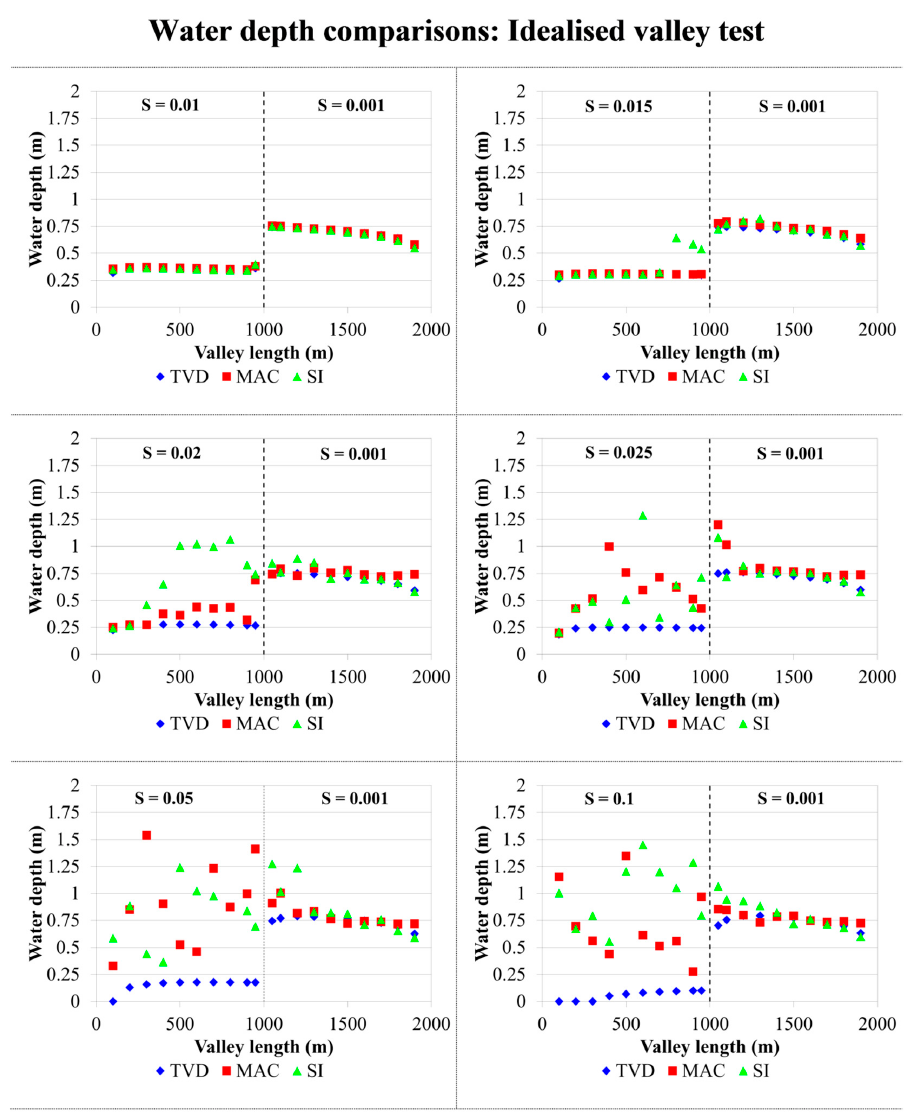
Figure 3. Predicted maximum water depths for the TVD, MAC and SI test cases for different variations of the idealised valley test case.